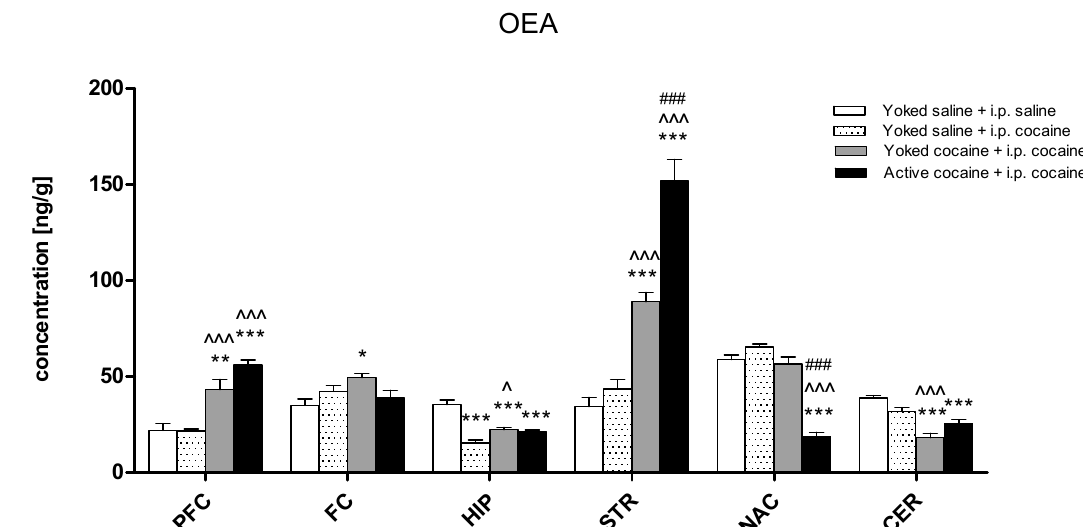
Figure 4. Levels of oleoylethanolamide (OEA) in brain structures in rats previously self-administered cocaine (14 days) (Active cocaine) or which passively received cocaine (Yoked cocaine) or saline (Yoked saline) and underwent extinction training (10 days) and drug-induced reinstatement (10 mg/kg cocaine i.p. or saline i.p.). N = 7–8 rats/group. All data are expressed as the means ± SEM. * p < 0.05, ** p < 0.01, *** p < 0.001 vs. Yoked saline + saline i.p.; ^ p < 0.05, ^^ p < 0.01, ^^^ p < 0.001 vs. Yoked saline + cocaine i.p.; # p < 0.05, ## p < 0.01, ### p < 0.001 vs. Yoked cocaine + cocaine i.p. A description of the abbreviations has been placed under Figure 2.